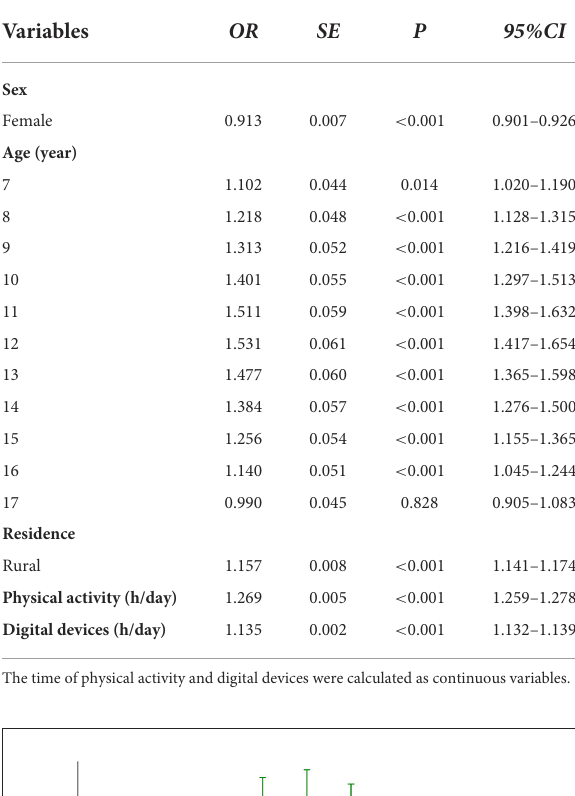
higher in primary grades one and two. The proportion of moderately poor visual acuity remained similar among the 12 grades (6–18 years)